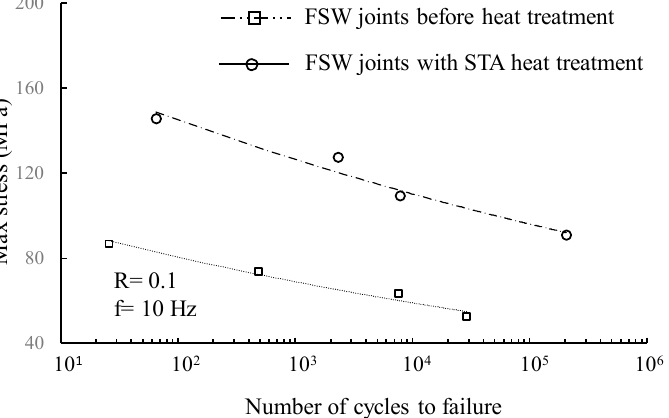
Figure 12. S–N curves of LPBed joints and their comparison with that of friction stir processed sam- Figure 12. ples. processed samples.